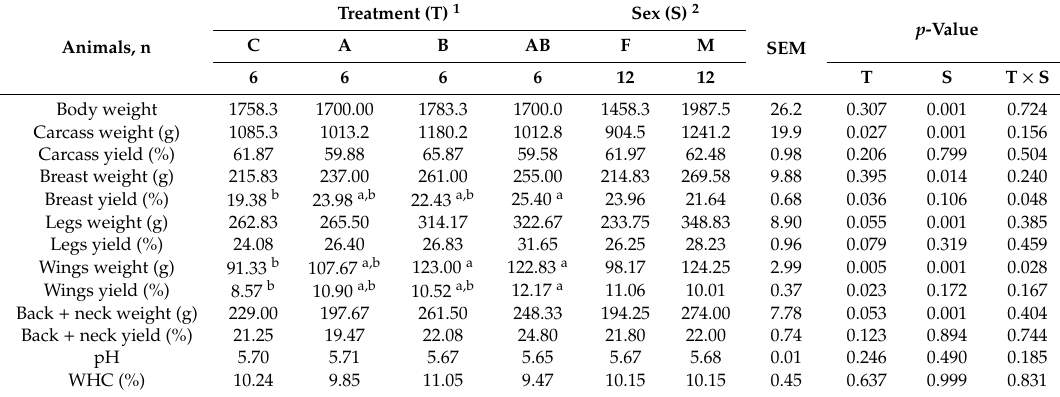
Table 5. E ff ect of the treatment and sex on s laughter traits, pH and WHC of Kuroiler chicken reared under tropical climatic